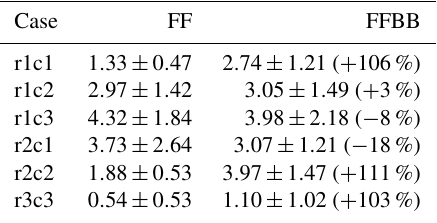
Table 4. The averaged precipitation (mm3h − 1 ) of FFBB and FF for each selected case over the main convection area in the Sumatra region (r1) and the Borneo region (r2). Parentheses in the third col- umn show the difference in percentage between FFBB and FF (i.e., ( FFBB-FF )/ FF ×